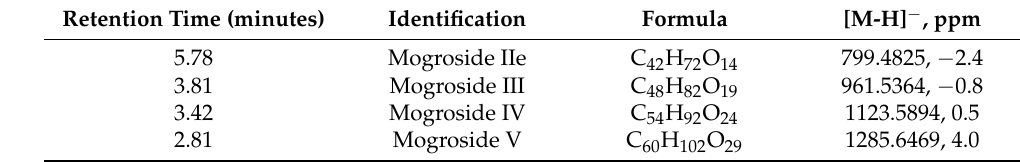
Table 1. LC-MS identification of Mogrosides.